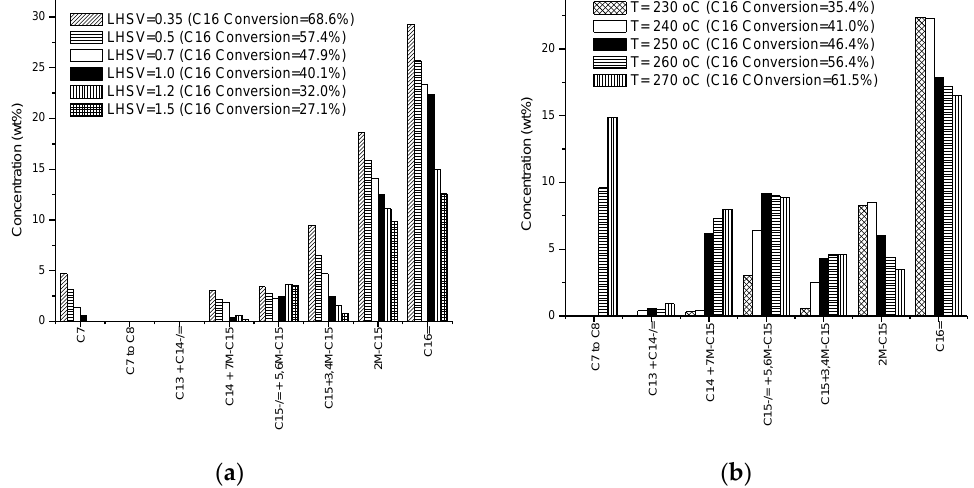
Figure 4. Product distribution for hydro-isomerisation of n-C 16 (C 16 ) by Pt-Cl/ H -β, P = 5.0 MPa& GHSV = 1180 mln/(g.cat).h for ( a ) different LHSV and ( b ) different operating temperature (Based on test method ASTM D2887) (Heptane:C 7 , Octane and isomers (ΣC 8 ):C 7 to C 8 , Tridecane + Tetradecene:C 13 + C 14-/= , Tetradecane + 7-methyl pentadecane+ 4-ethyl pentadecane: C 14 + 7M-C 15 , Pentadecene + 5 & 6-methyl pentadecane: C 15-/= + 5,6M-C 15 , Pentadecane + 3 & 4-methyl pentadecane: C 15 + 3,4M-C 15 , 2-methyl pentadecane: 2M-C 15 , Hexadecene: C 16-/= , n-Hexadecane: C 16 ).